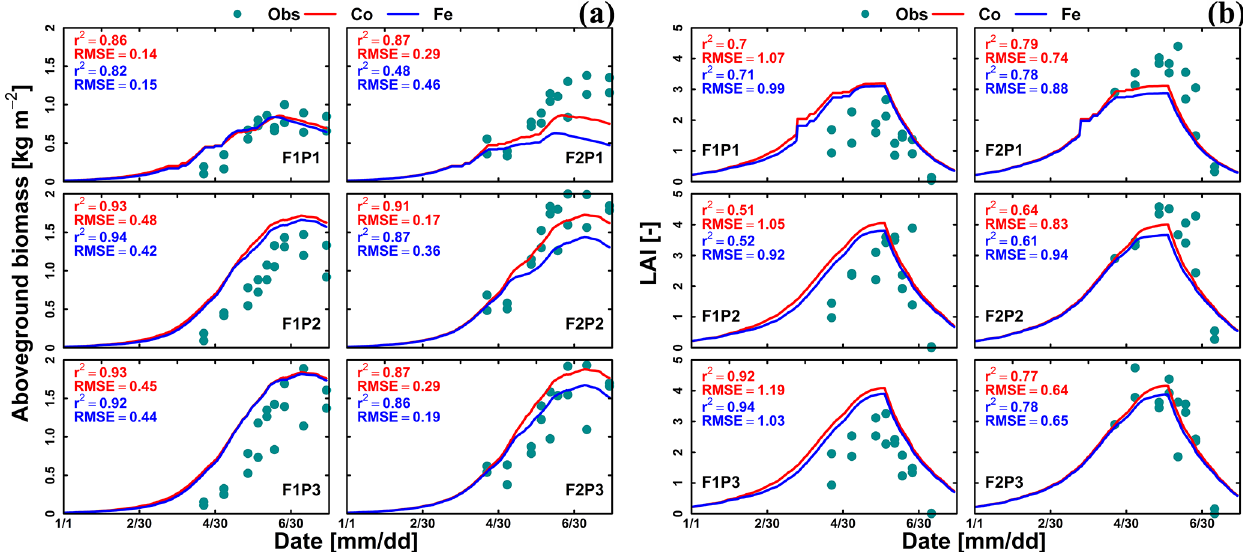
Figure 3. Comparison between observed (cyan dot) and simulated (a) aboveground dry matter and (b) LAI by Couvreur (Co; solid red line) and Feddes (Fe; solid blue line) model in the sheltered (P1), rainfed (P2), and irrigated (P3) plots of the stony soil (F1) and the silty soil (F2). Note that crop germination was on 26 October 2015; data are shown here from 1 January to harvest on 23 July 2016. RMSE in (a) is kgm − 2 while RMSE in (b) is unitless.